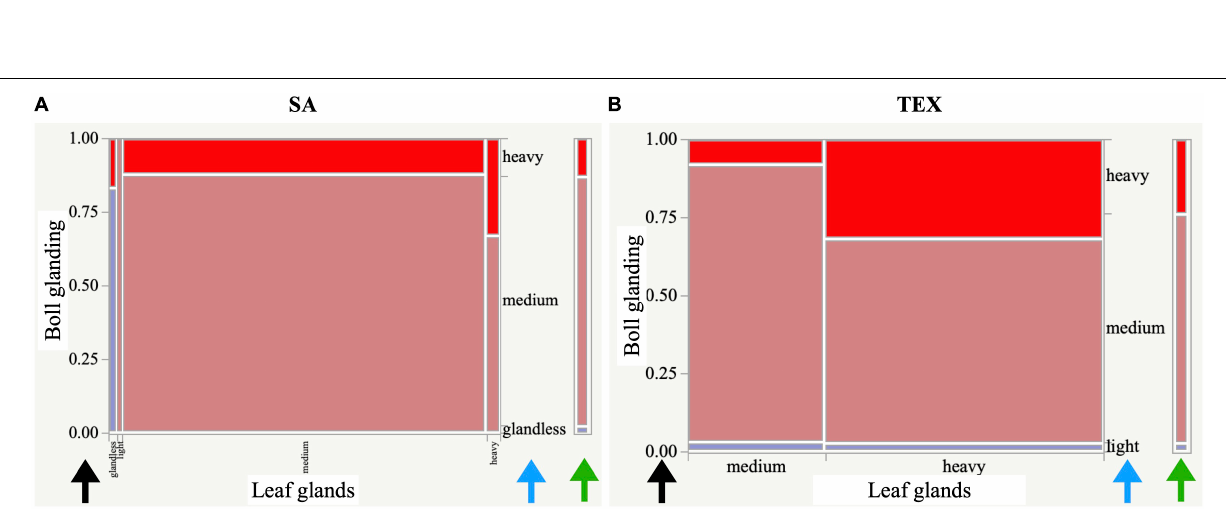
FIGURE 5 | Mosaic plots displaying the degrees of glanding in leaves versus bolls. Plots are shown for (A) the SA and (B) TEX groups. The plots are divided into rectangles as a stacked bar chart so that the vertical length of each rectangle reflects the proportion of the Y variable in each state (blue arrows) of the X variable and is a graphical representation of a contingency table. The scale of the vertical axis at left on each plot shows the response probability (black arrows). The whole axis is equivalent to a probability of one, representing the total sample. Fill colors are showing boxes reflecting the phenotype on the Y -axis with legend to the right of the figure (green